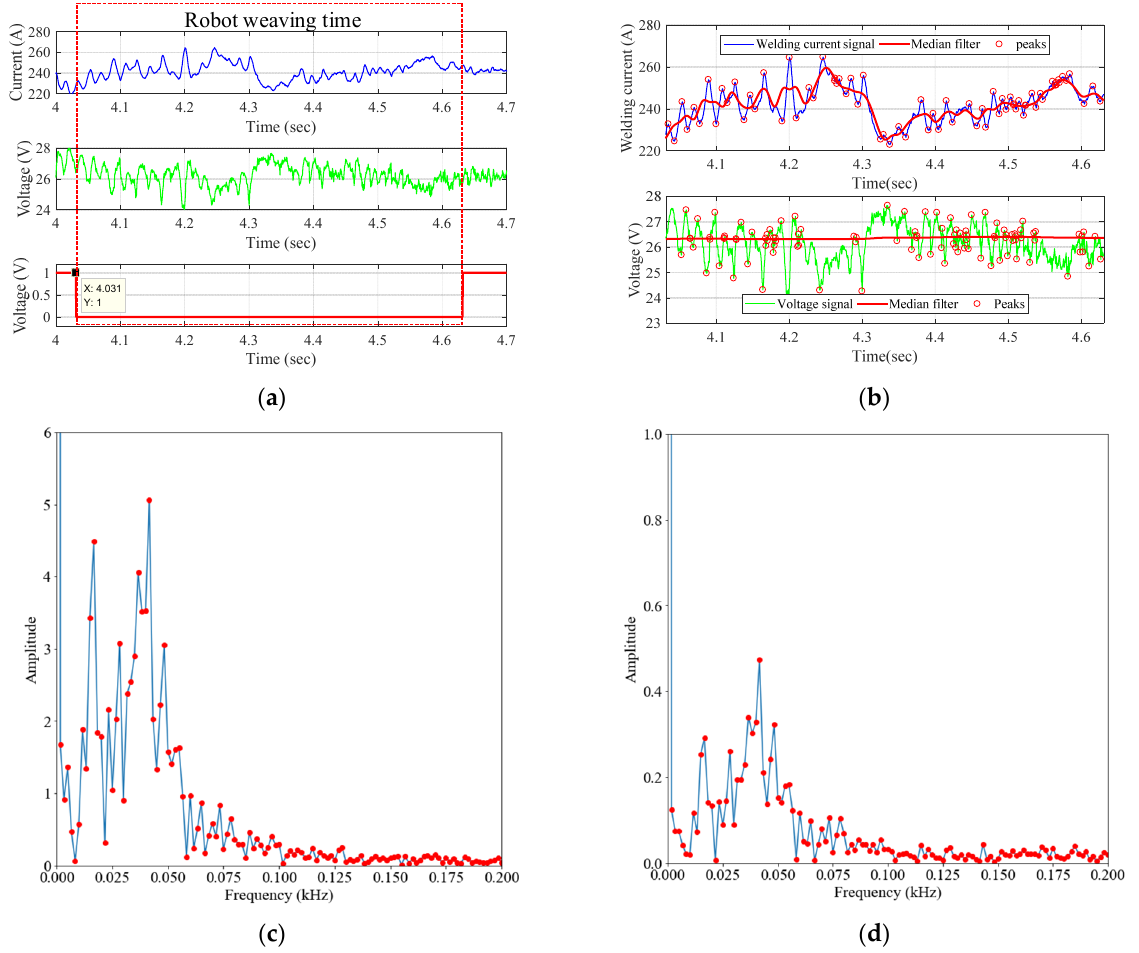
Figure 4. Time and frequency domain feature extraction: ( a ) raw data of the welding current and voltage signal, ( b ) feature point generation using the median filter, ( c ) FFT result of the welding current signal, and ( d ) FFT result of the voltage signal. Table 4. Definitions of feature